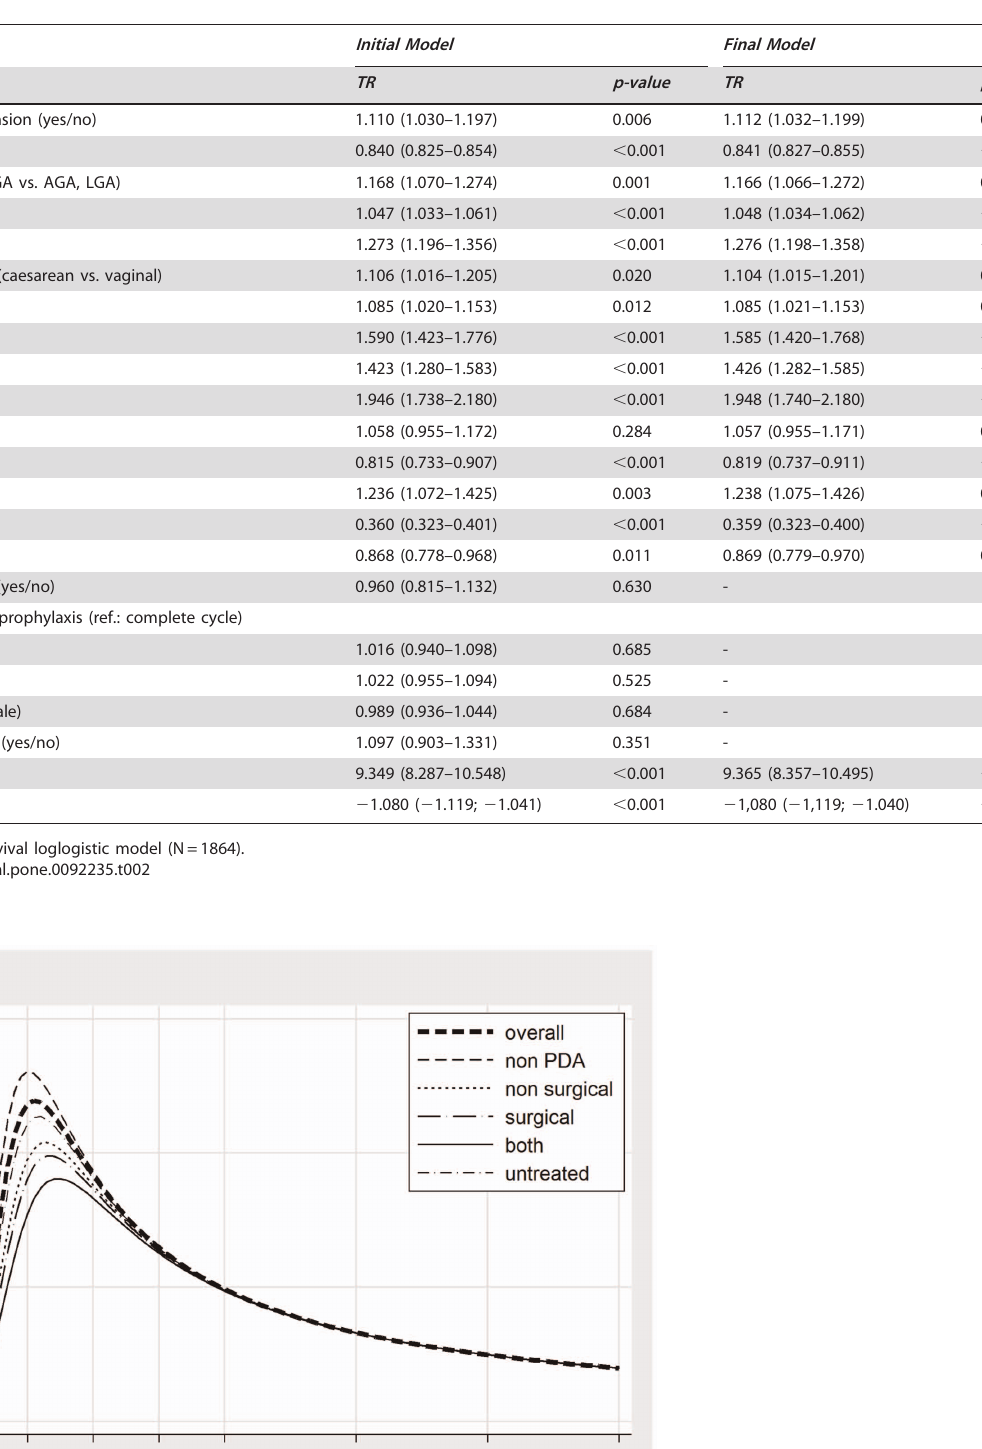
Table 2. Predictors of time to